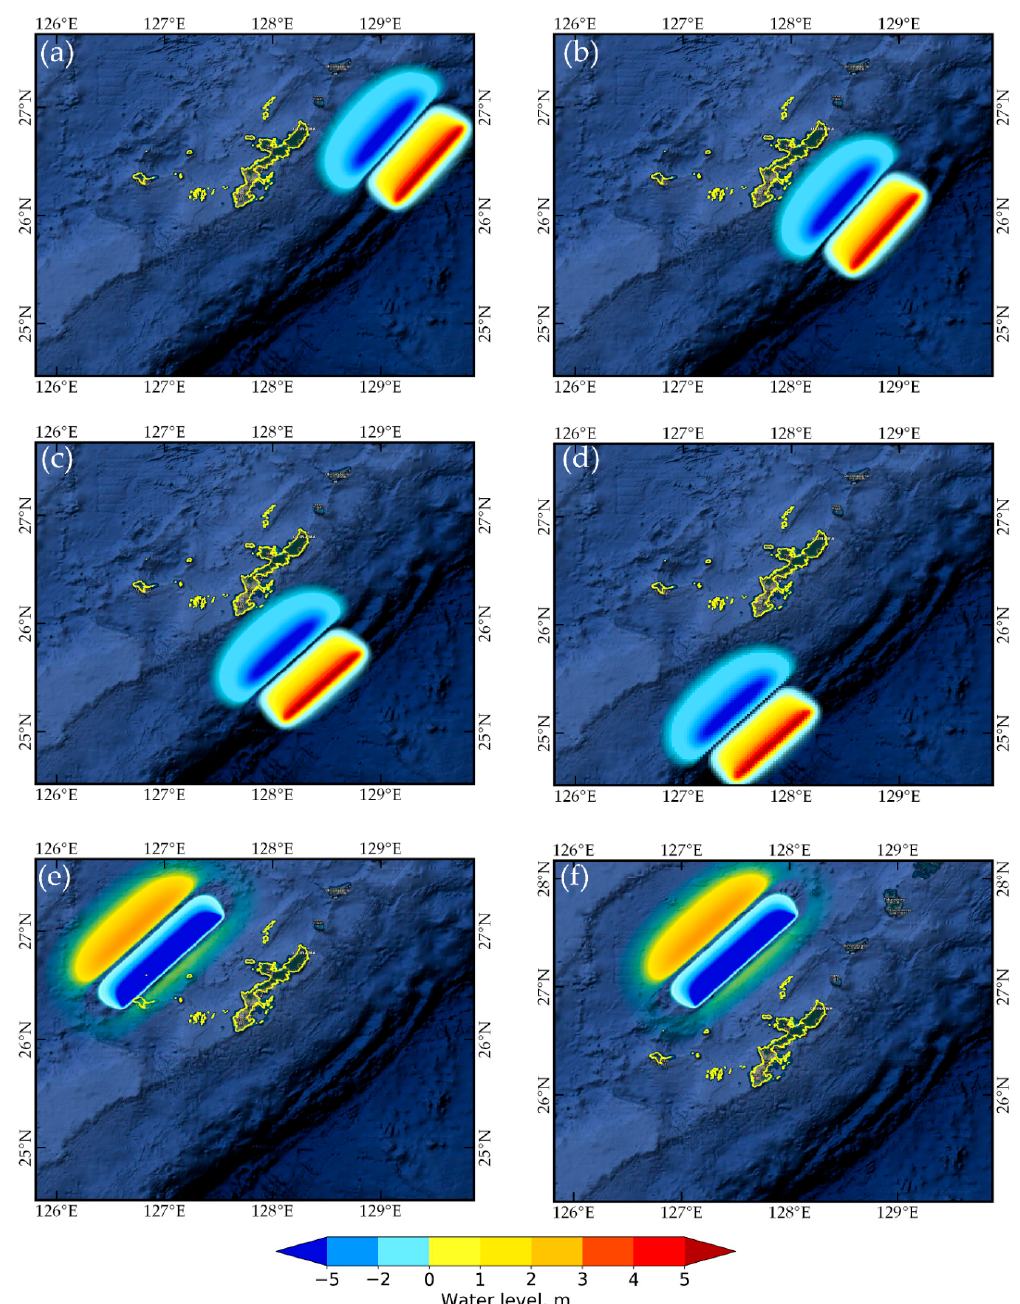
Figure 7. Initial water level generated by the fault parameter of the earthquake scenario. ( a ) F1, ( b ) F2, ( c ) F3, ( d ) F4, ( e ) F5, and ( f )